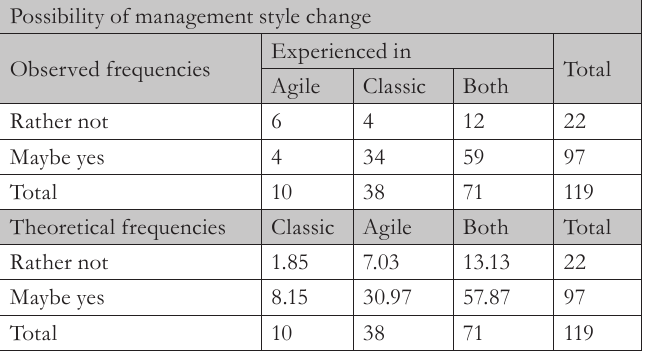
Tab. 5 – Results: simplified data for YES and NO answers. Source: own